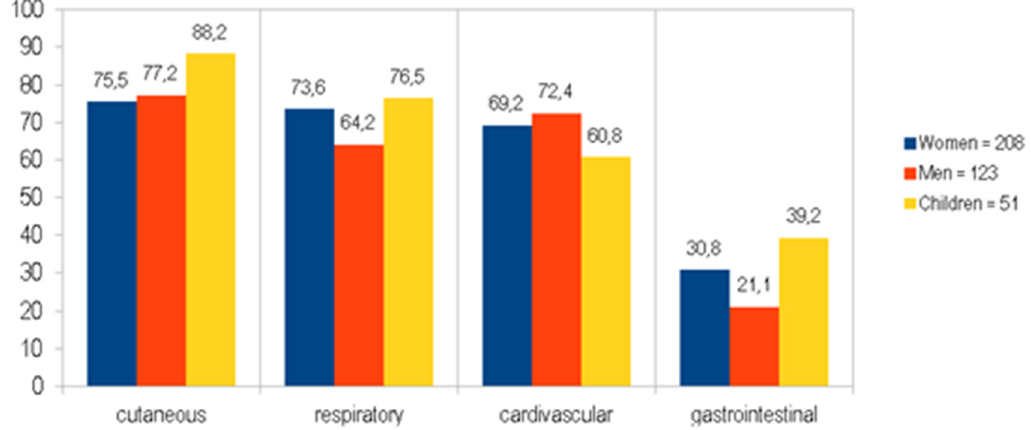
Figure 3. Organ systems involved (%) in anaphylaxis with groups divided into women, men, and children.